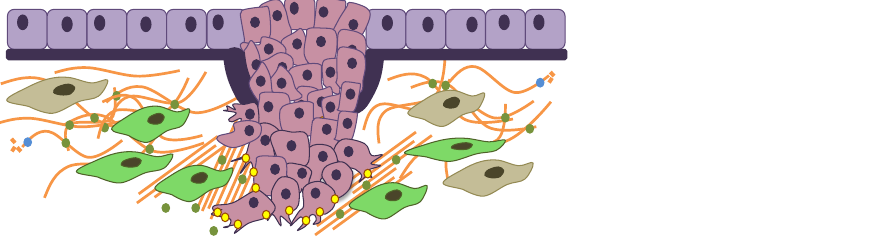
Figure 3. ECM remodelling during cancer progression and initiation. ( 1 ) Epithelial neoplastic cells proliferate rapidly, inducing strain on the basement membrane. ( 2 ) Basement membrane bulges due to mechanical strain. Adjacent cancer-associated fibroblasts increase deposition of collagen. Stromal-derived lysyl oxidase (LOX) aligns collagen. ( 3 ) Neoplastic cells breach membrane and migrate along aligned collagen. (Adapted from Lu et al. [6].)